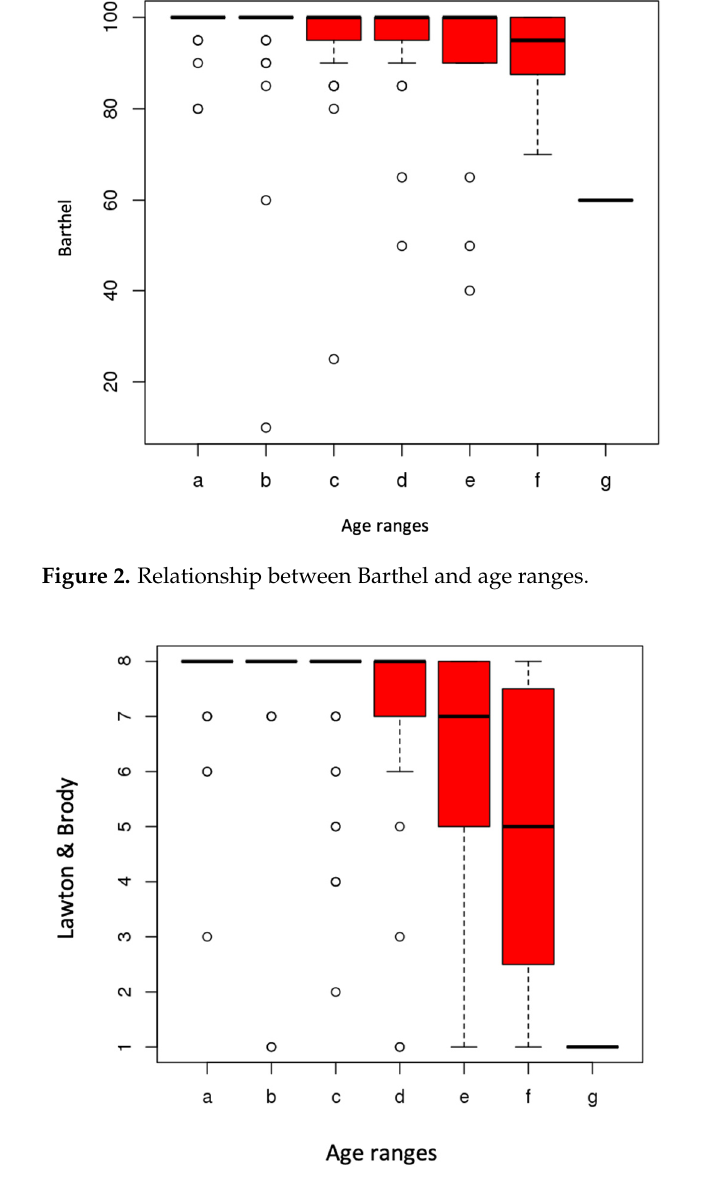
Figure 3. Relationship between Lawton and Brody and age ranges.